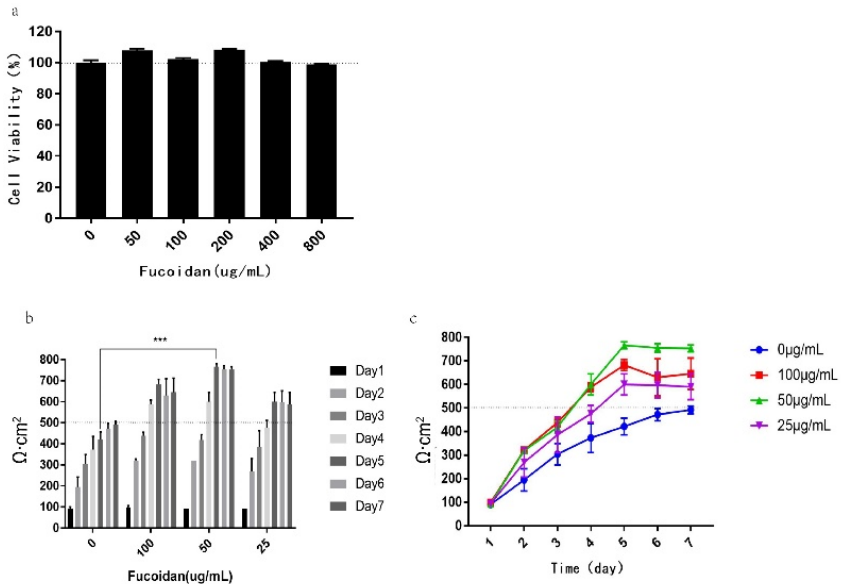
Figure 2. Effect of fucoidan concentration on Caco-2 model establishment. ( a ) The cell viability in macrophages detected after incubation with fucoidan for 24 h by MTT (3-(4,5-dimethylthiazol-2yl)- 3,5-diphenytetrazolium bromide). ( b ) Histogram of TEER value growth under different fucoidan concentrations. ( c ) Line chart of TEER value growth trend at different fucoidan concentrations. The data is shown as ± SD ( n = 3); *** p < 0.001.